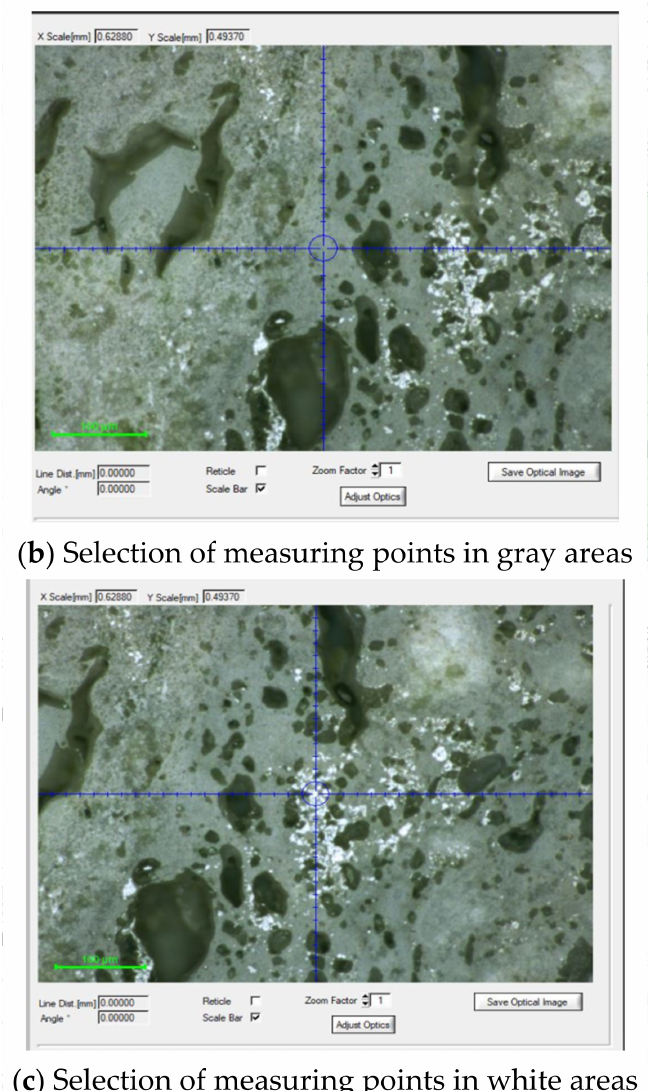
Figure 6. Selection of test points for di ff erent